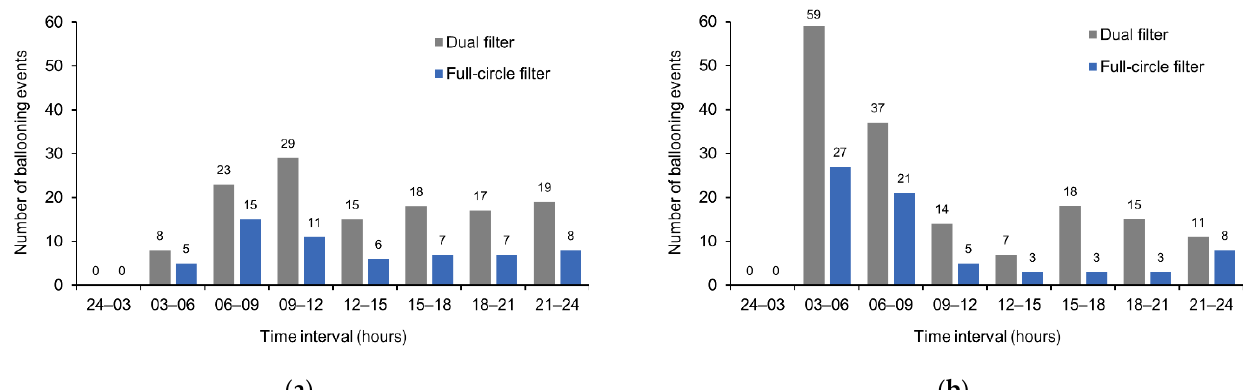
Figure 5. Distribution of ballooning events over 24 h with the full-circle filter and the dual filter in ( a ) participants with a colostomy (n = 20), and ( b ) participants with an ileostomy (n = 20). Data are presented for the ITT analysis set. Time intervals are indicated using the 24 h clock. ITT = intention- to-treat.